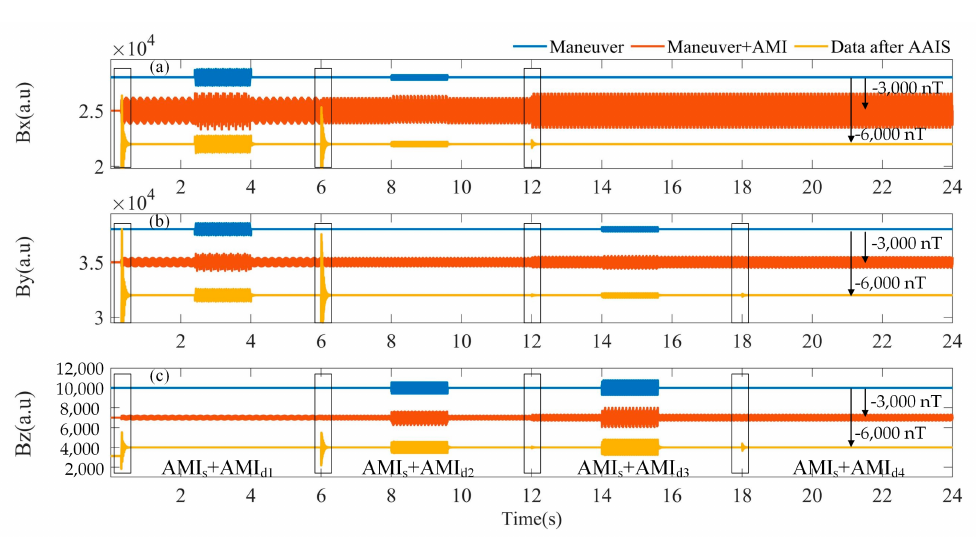
Figure 6. The suppression effect of AAIS on dynamic AMI. ( a ) X component; ( b ) Y component; ( c ) Z component. The blue curve shows the magnetic field change on each axis of the triaxial magnetometer, which is preset to simulate the plane maneuver. The orange curve shows the measurements of the triaxial magnetometer when AMIs exist. The yellow curve shows the data processed by AAIS.